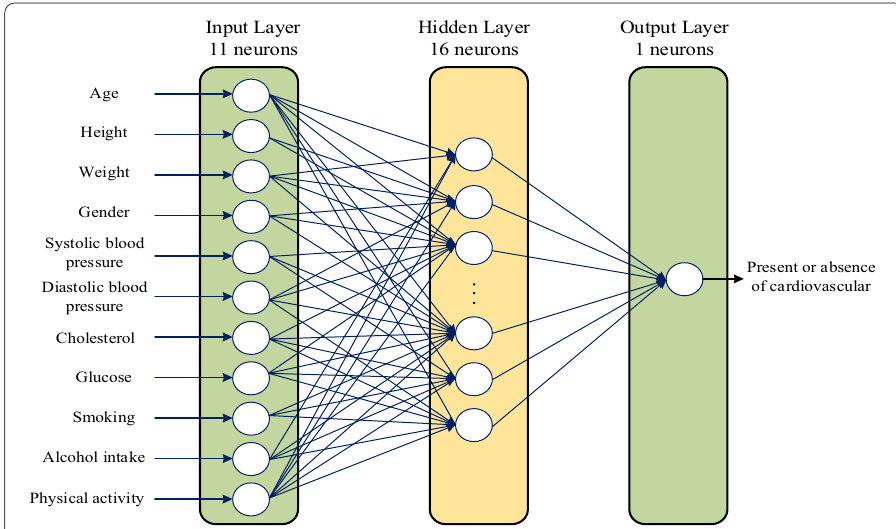
Fig. 5 The fully connected artificial neural